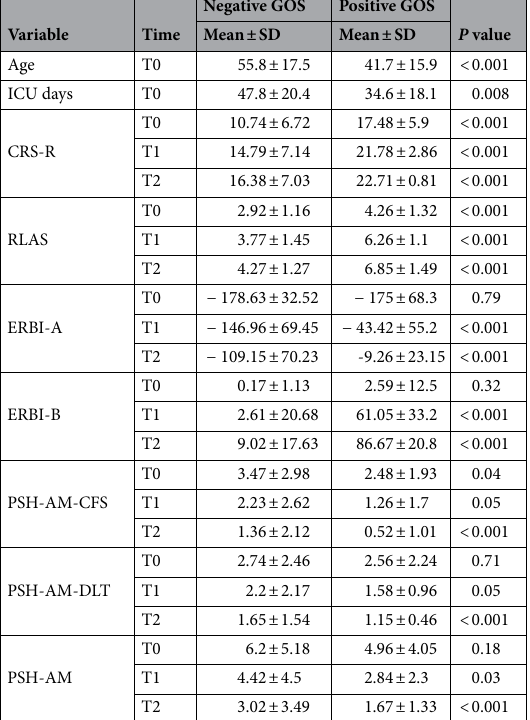
Figure 2 shows the patient scores regarding each dimension at the three evaluation time points (T0: baseline, T1: 4 months after the event, T2: at discharge). Patients were identified according to their outcome (positive: blue dots, negative: red dots). The figure shows a general increase in the scores over time for Dimension 1, with a larger increase observed for patients with a positive outcome. Patients in the two groups show overlapping scores for Dimension 2.